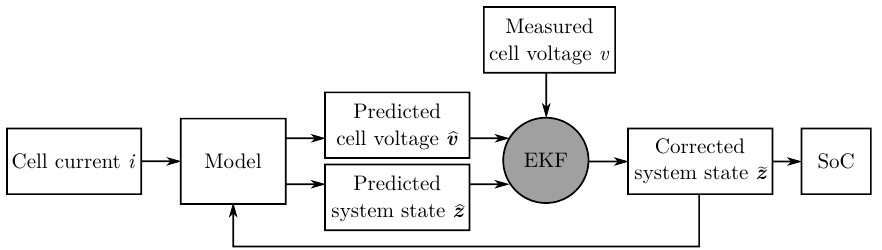
Figure 1. Principle of an EKF for battery SoC